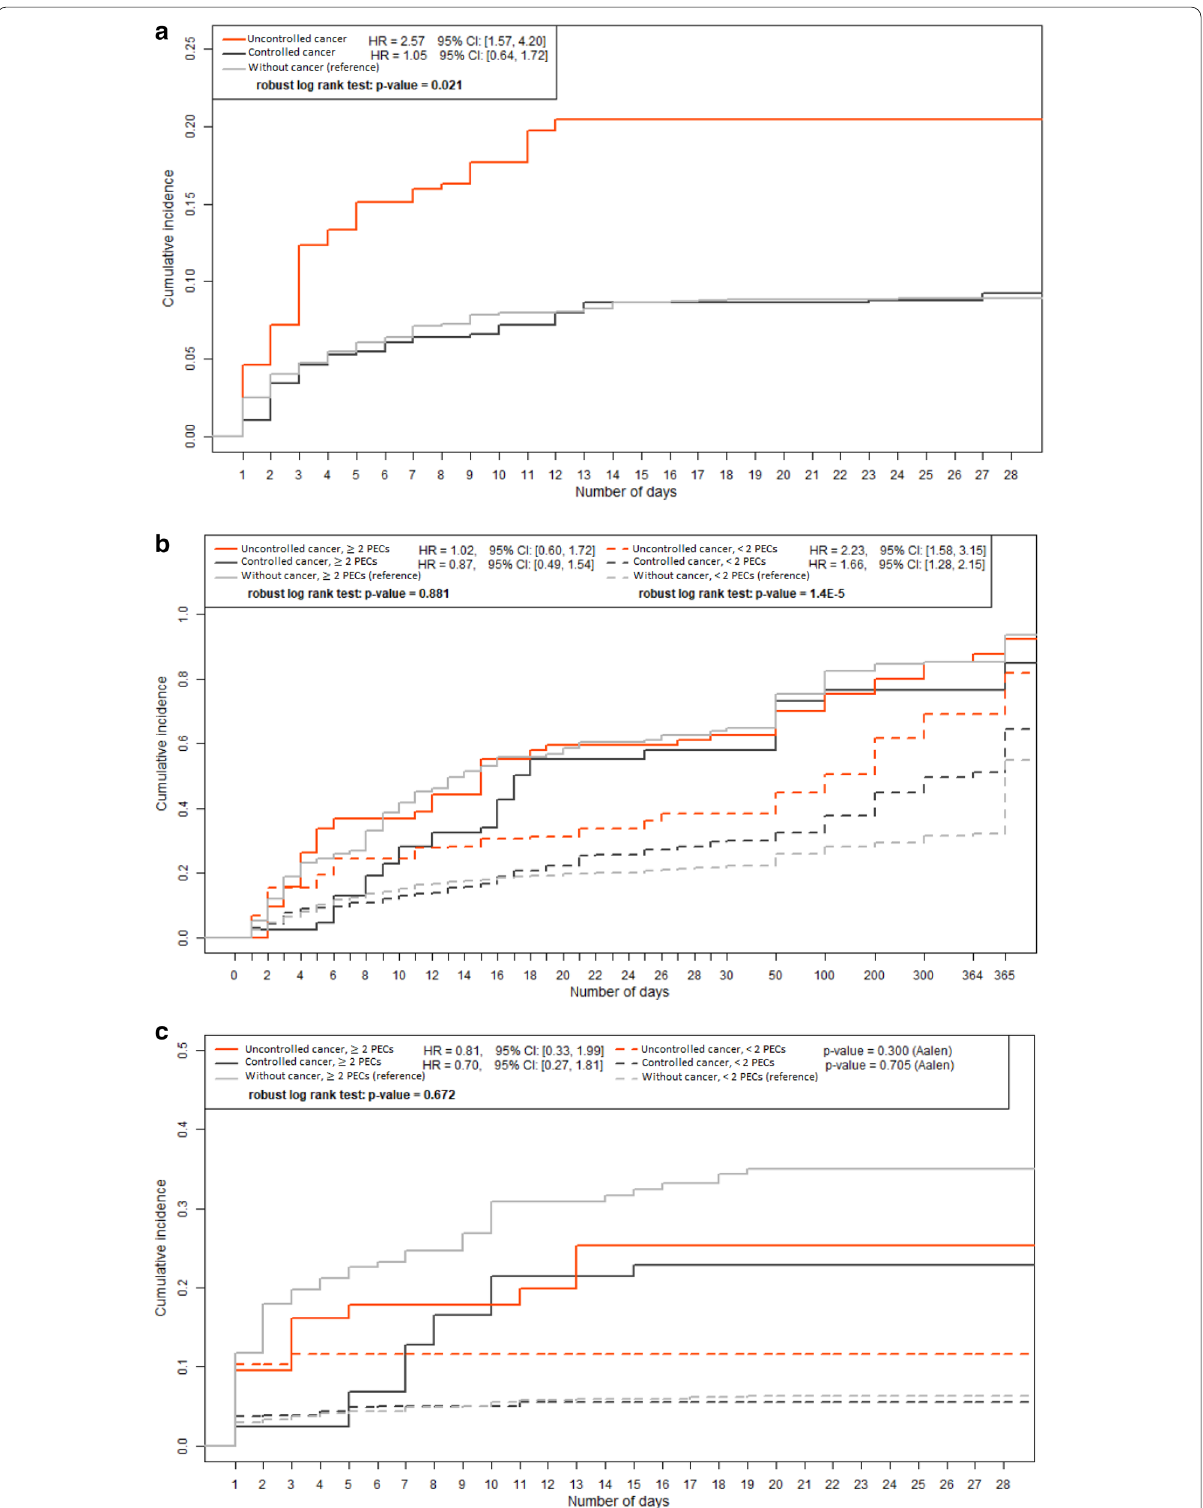
Fig. 2 a Time from ICU admission until at least 2 PECs during ICU stay (weighted). b Time from ICU admission until death (weighted). c Time from ICU admission until TLD during ICU stay (weighted). TLD treatment limitation decision, PEC perceptions of excessive